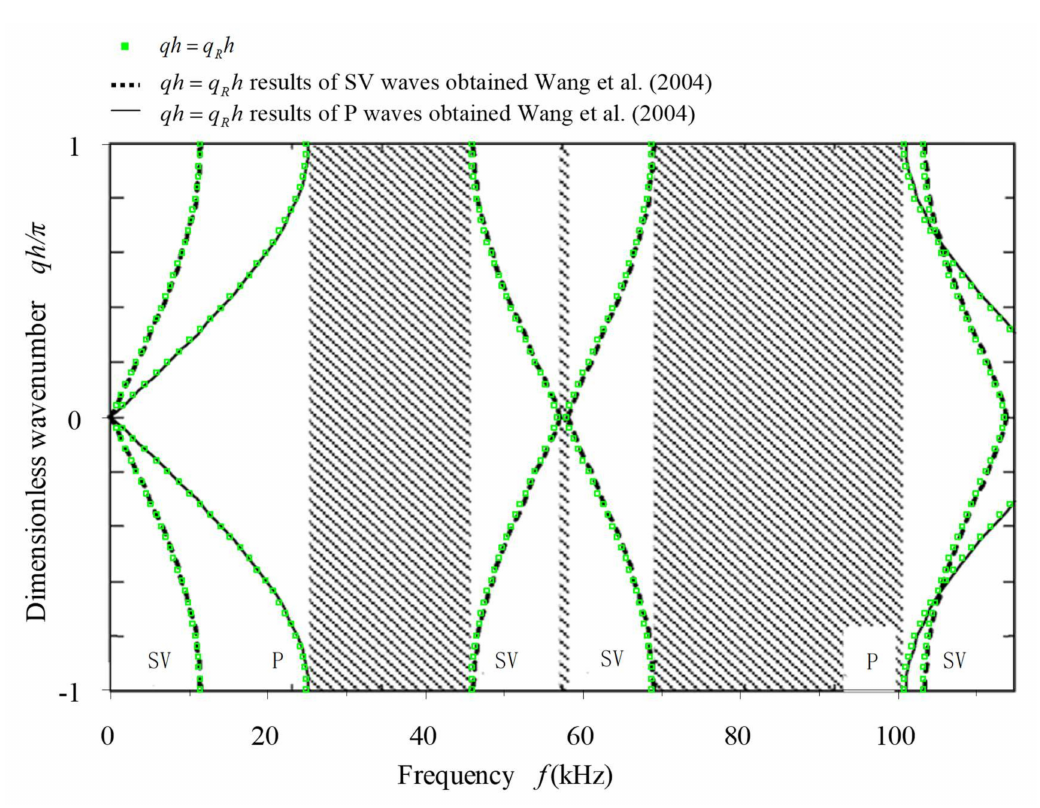
Figure 2. The dispersion curves of Floquet in-plane waves propagating perpendicular to layering. The results by the MRRM and the MTM are shown with bright green box and black line with the dashed and solid lines corresponding to the SV-waves and the P-waves, respectively [6]. The shaded areas represent band